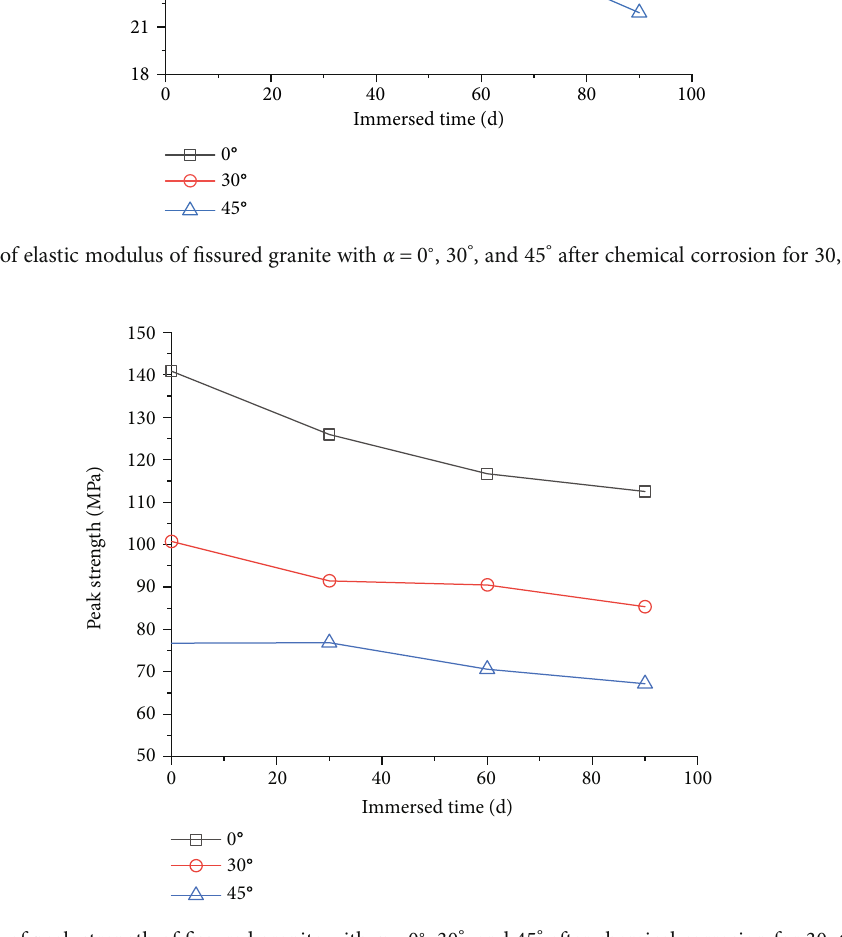
Figure 13: Variation of peak strength of fi ssured granite with α = 0 ° , 30 ° , and 45 ° after chemical corrosion for 30, 60, and 90 days. Table 3: The results of the uniaxial compression test of fi ssured granites under the action of chemical solution. Immersed